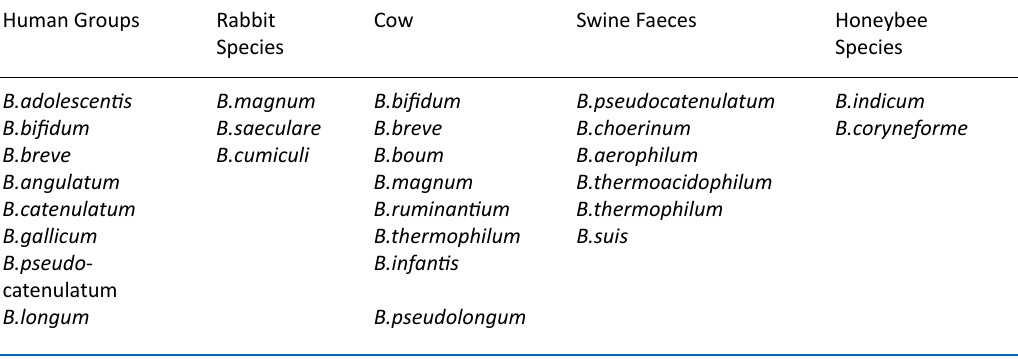
Table 3. Distribution of species of Bifidobacterium Human